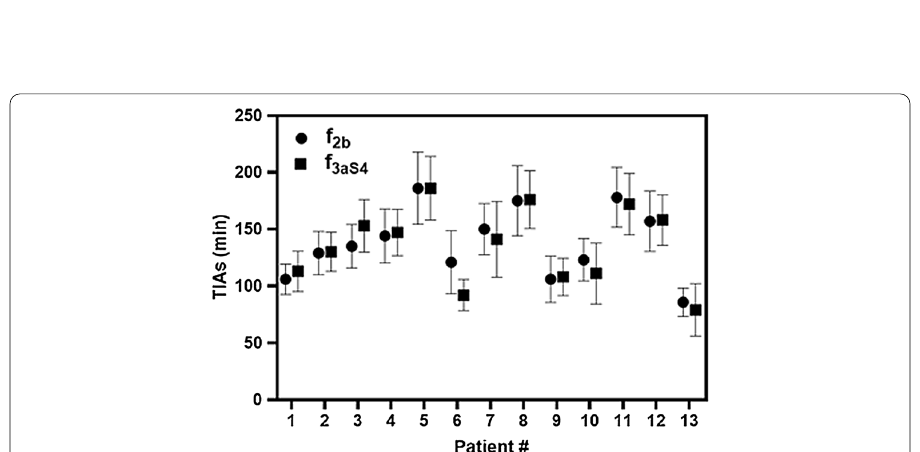
Fig. 2 Kidneys TIAs calculated from the two functions most supported by the data, f 3 aS 4 and f 2 b , which were derived using the PBMS and IBMS method,